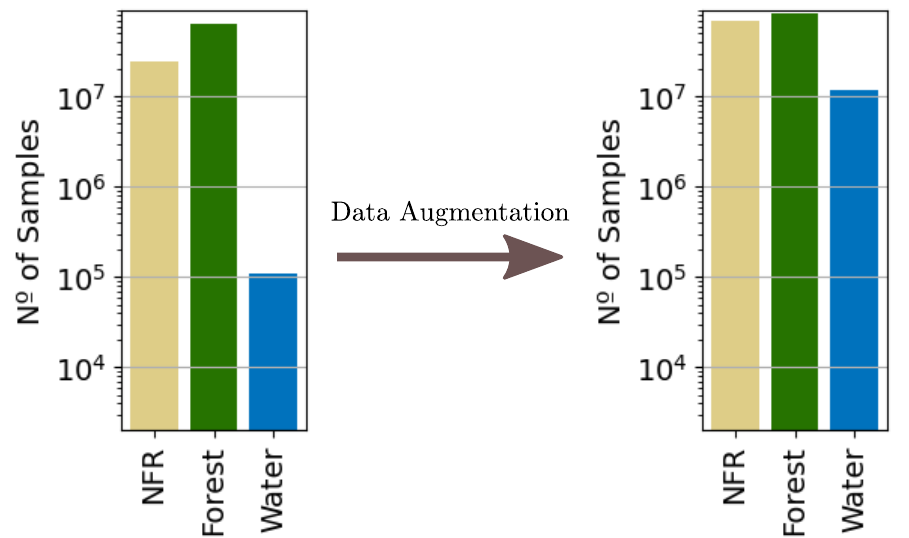
Figure 5. Original number of samples for each of the three high-level classes of interest ( left ) and data availability after balancing ( right ). We artificially augmented Water patches and undersampled the ones dominated by the NFR and Forest